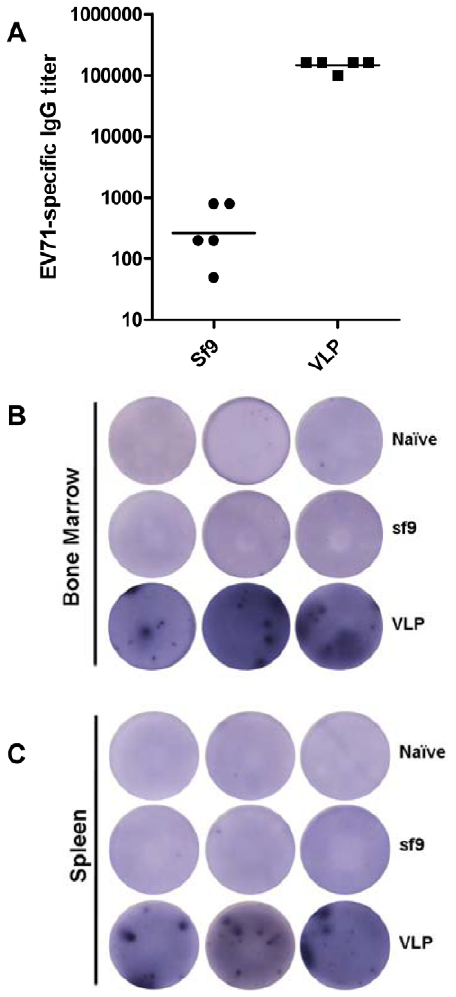
Figure 5. Antibody responses following VLP immunization. Groups of five mice were injected i.p. at weeks 0, 2 and 5, with alum- absorbed antigens: EV71-VLP equivalent to 5 m g VP0, or the control lysate similarly prepared from uninfected Sf9 cells. The immunized mice were sacrificed at week 7 (2 weeks after the last immunization), and the serum, bone marrow and spleen samples were collected and assayed. Results are representative of two independent experiments. (A) EV71- specific serum IgG titers of the Sf9 and the VLP groups. Each symbol represents a mouse, and the line indicates the geometric mean value of the group. (B) ELISPOT analysis of EV71-specific antibody-secreting cells in mouse bone marrow. Samples from naı¨ve mice were used as the control. Results of triplicate wells are shown. (C) ELISPOT analysis of EV71-specific antibody-secreting cells in mouse spleens. Samples from naı¨ve mice were used as the control. Results of triplicate wells are shown. doi:10.1371/journal.pone.0057601.g005 the position of the loading well with a very high molecular weight, which could be aggregates due to the aberrant assembly of P1 (Figure 2D). The P1/3CD co-infected sample produced a major band of , 38 kDa and a minor band of , 28 kDa (Figure 2D), which are expected for processed VP0 and VP2 subunit proteins.